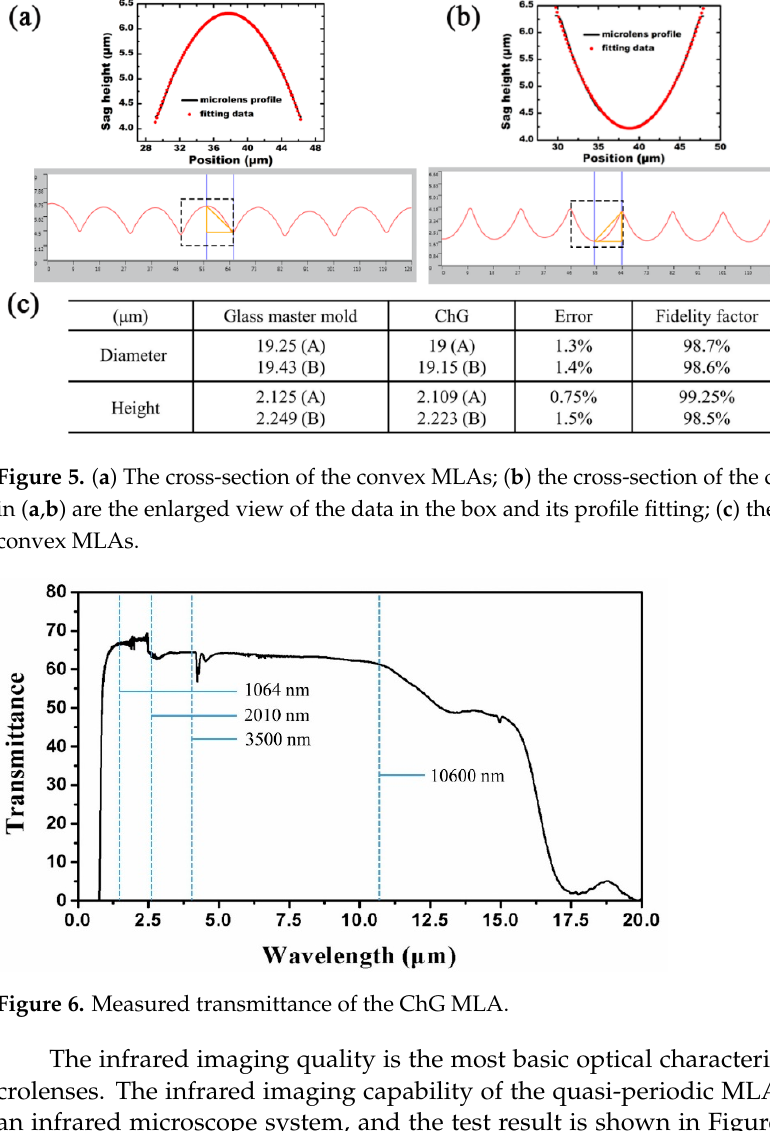
Figure 5. ( a ) The cross-section of the convex MLAs; ( b ) the cross-section of the concave MLAs; insets in ( a , b ) are the enlarged view of the data in the box and its profile fitting; ( c ) the fidelity factor of the convex MLAs.